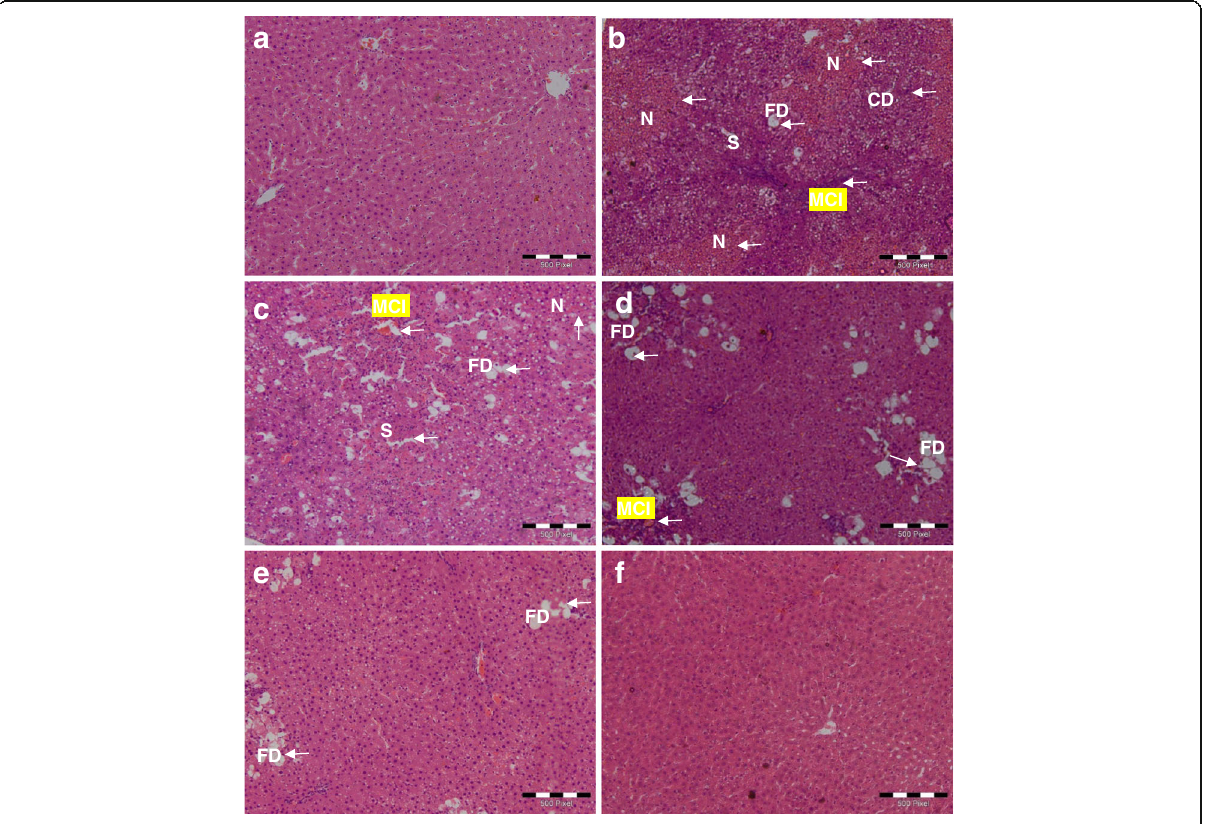
Fig. 6 Effect of C. nudiflora on CCl4-induced histopathological changes (H&E staining). a Control group, normal histopathology. b CCl4 (1 ml/kg b.wt.) hepatic necrosis (N), mononuclear cell infiltration (MCI), fatty degeneration (FD), sinusoidal spaces (S), and cell derangement (CD). c C. nudiflora (150 mg/kg b.wt. +